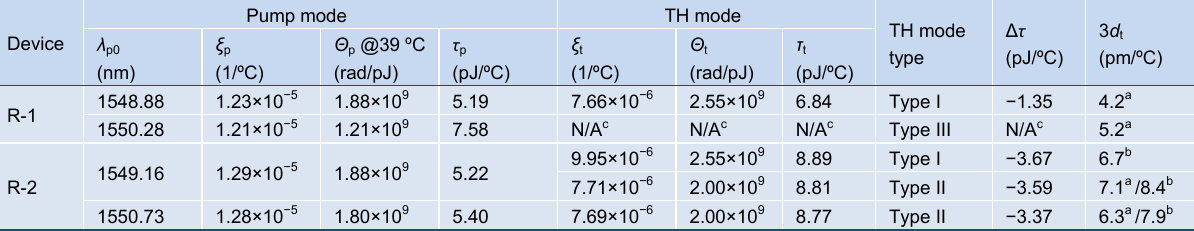
below the OSA resolution limit.